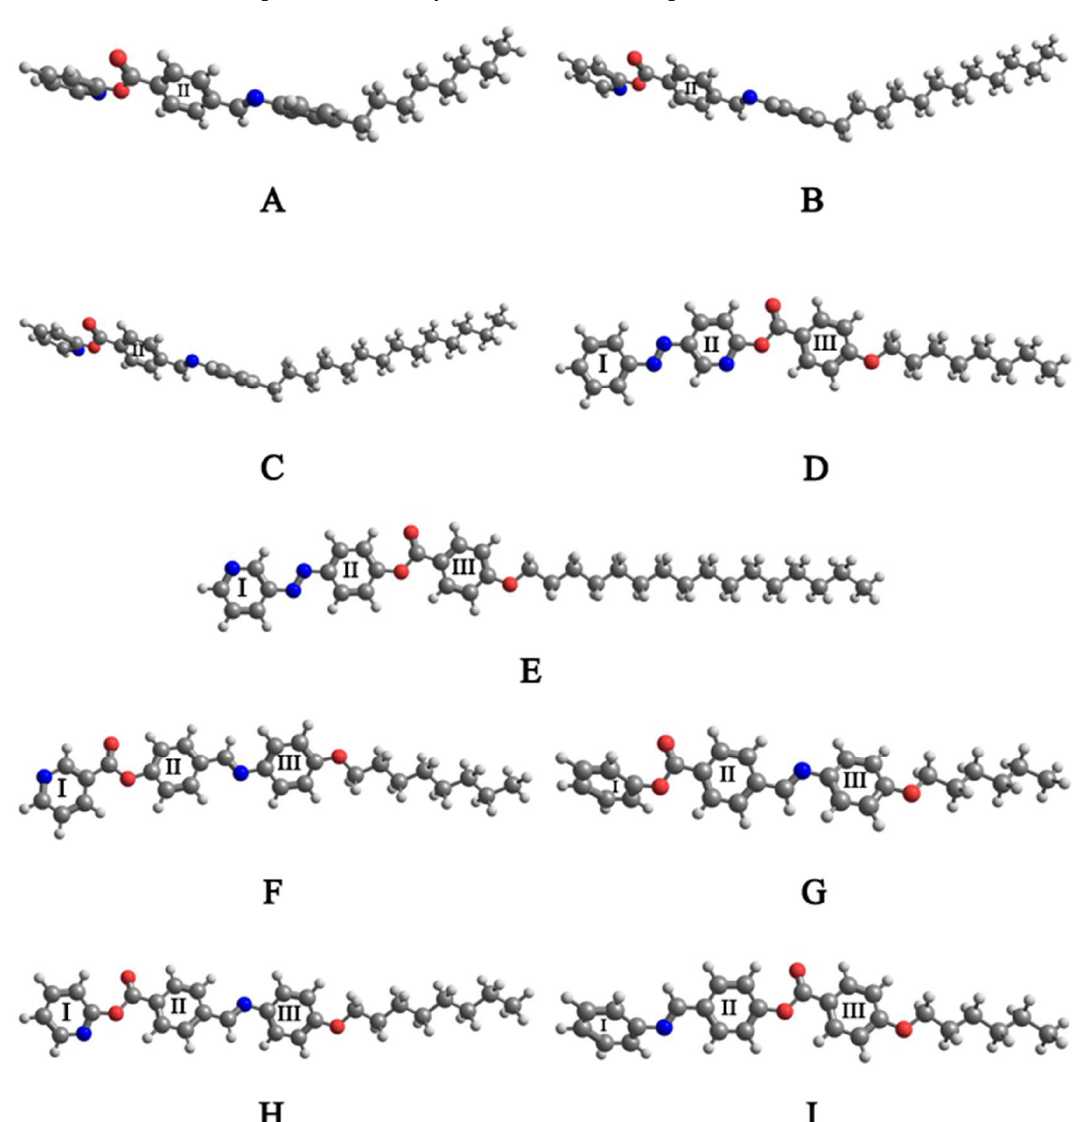
Figure 5. The estimated molecular geometry of A , B , C , D , E , F , G , H, and I compounds. The aspect ratio is another structural parameter that may explain the behavior of the mesophases as it can indicate the collision diameter of the compounds, so the intermolecular interaction increases when raising the aspect ratio values. Thus, we correlate in Table 3 and Figure 6 the mesomorphic parameters of the investigated compounds with aspect ratio values and the ratio of the width to the